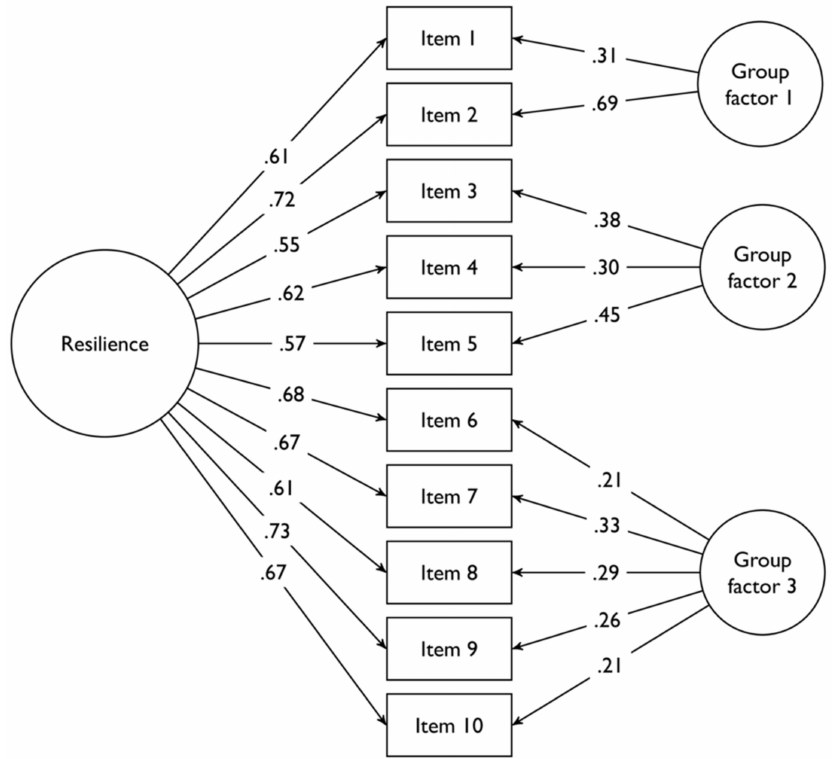
Figure A5. Factor structure resulting from the exploratory bifactor analysis of the Connor-Davidson Resilience